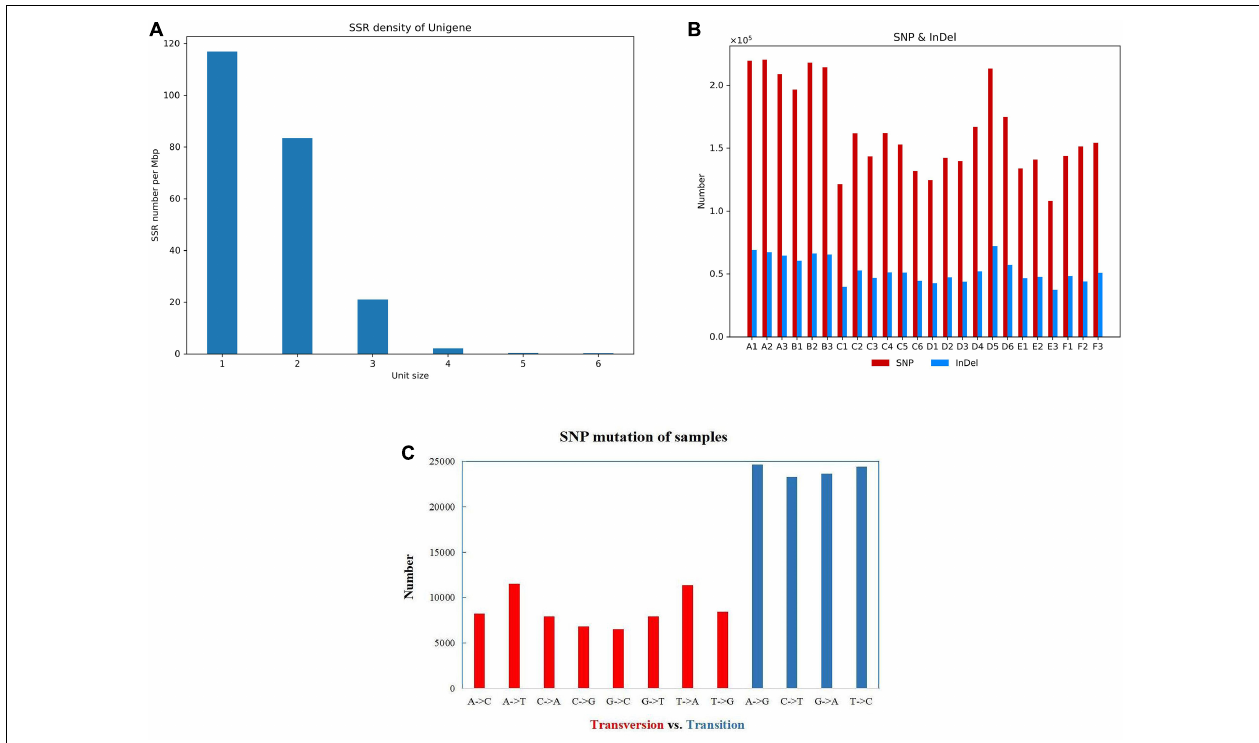
FIGURE 3 | The gene structure and the SNP analysis. (A) The density distribution of the SSR marker. The number on the x -axis represents the SSR repeat types. (B) The amount of SNP and InDel in different groups. (C) The SNP mutation of sample